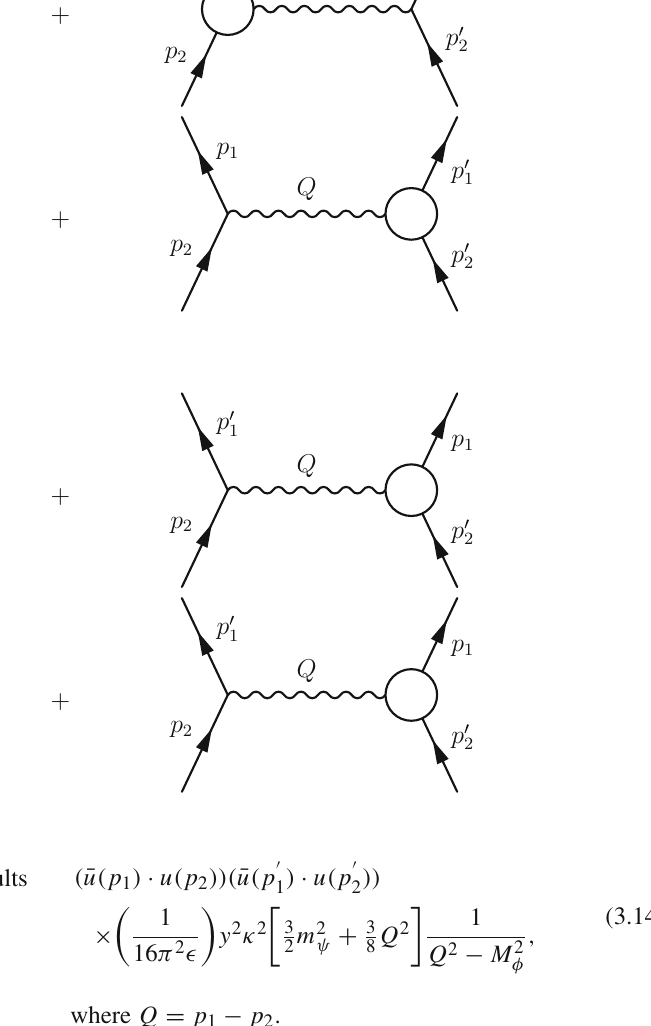
Fig. 11 S matrix contributions